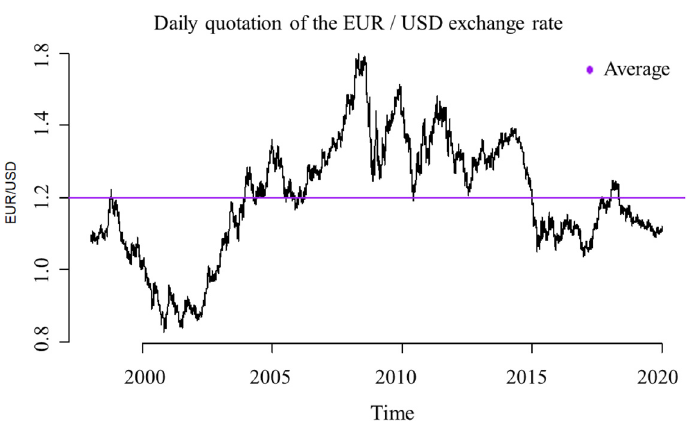
Figure 4. Daily prices of the EUR/USD exchange rate.